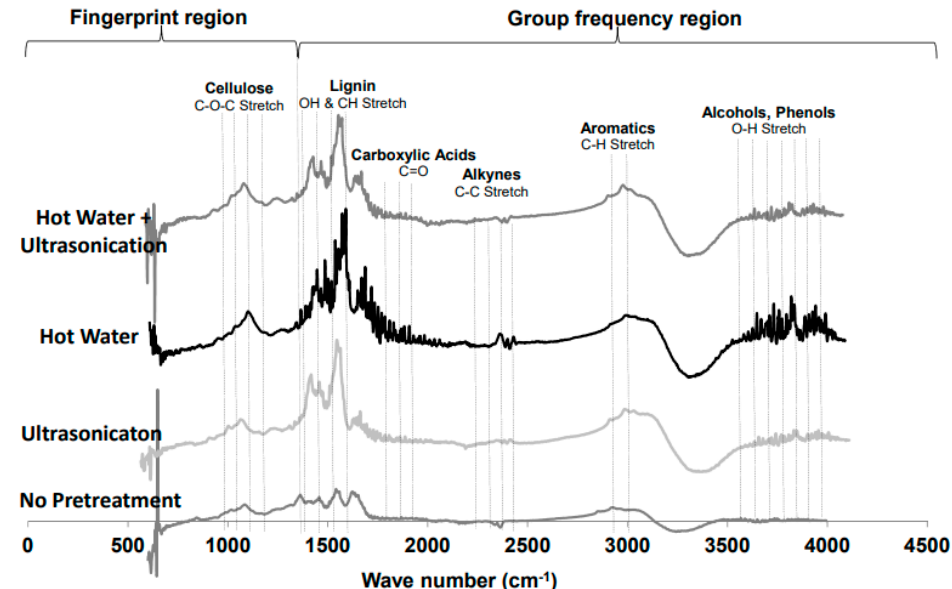
Figure 2. FTIR spectra of biogas produced from the digestion of microalgae.